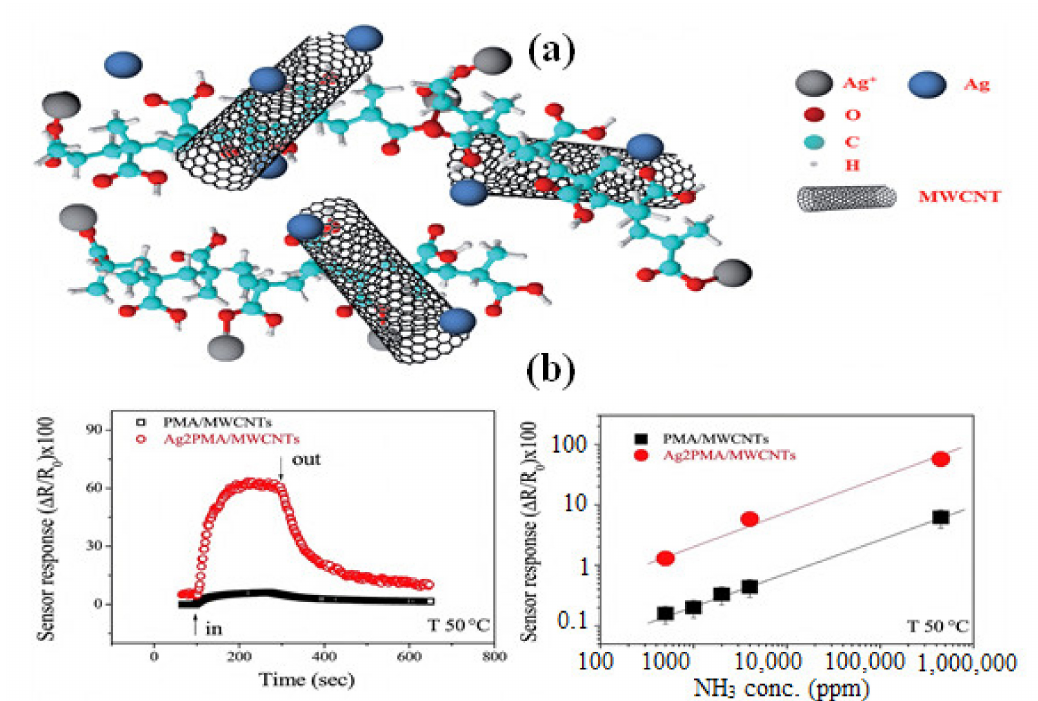
Figure 11. ( a ) Scheme for AgPMA/MWCNTs composite, ( b ) comparison between dynamic responses of PMA/MWCNTs and Ag2PMA/MWCNTs sensors to 44.7% of NH 3 at 50 ◦ C, copied with permission from Ref. [155], Royal Society of Chemistry, 2014.